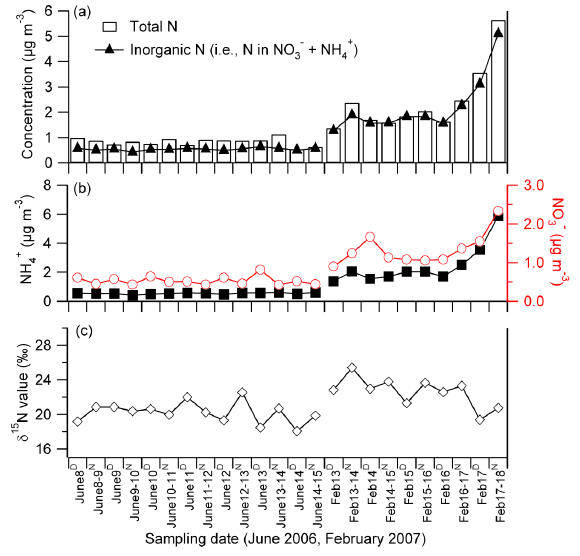
Fig. 7. Temporal variations in concentrations of (a) total nitrogen (TN) and inorganic nitrogen, (b) NH + ues of